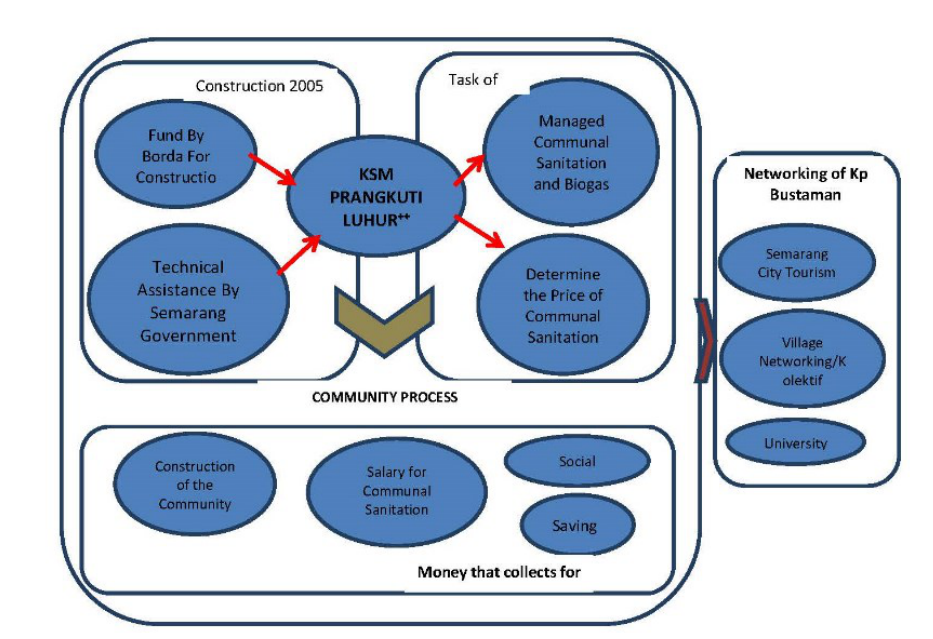
Figure 4. Community Process and Partnership Network Model. Source: Researcher Analyzed,